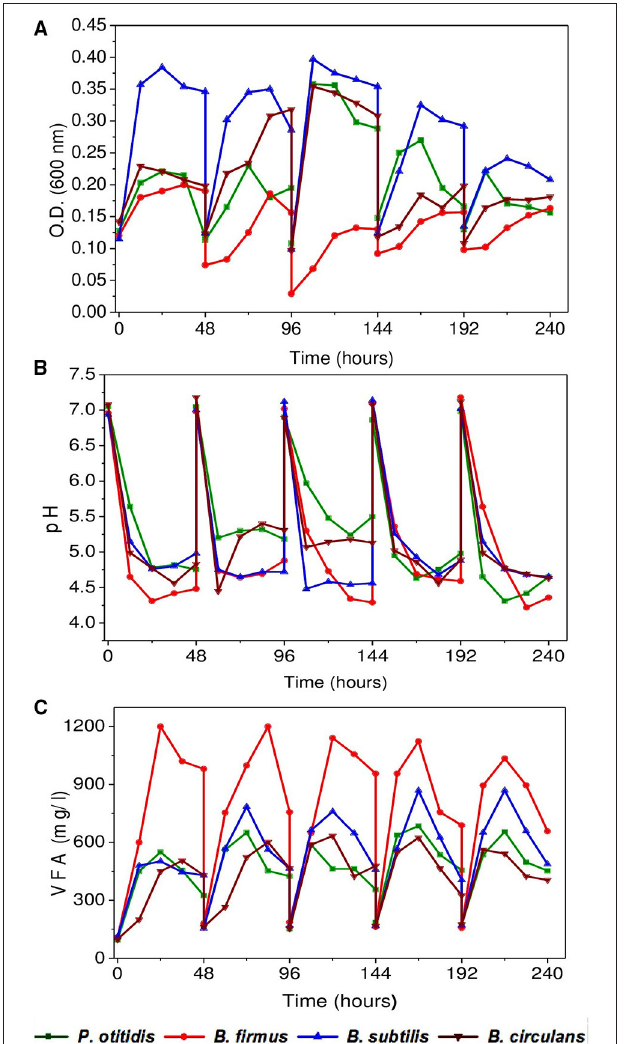
FIGURE 3 | (A) Variation in COD concentration removal (mg/l) with isolated strains (B) Variation in COD removal efficiency (%) with isolated strains (C) Variation in substrate degradation rate (cumulative) (kg · COD R /m 3 -day) with isolated